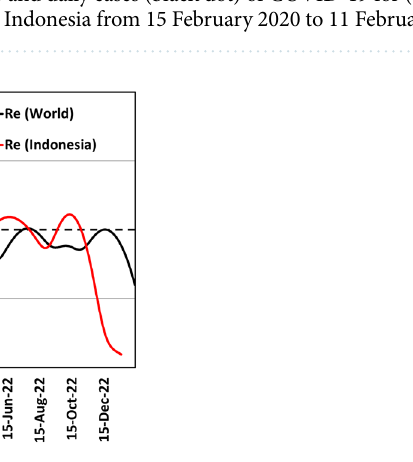
Figure 1. The model of multiple waves infection of the total cases (purple line), daily cases (red line), and compared with the observed data of total cases (blue dot) and daily cases (black dot) of COVID-19 for ( a ) the